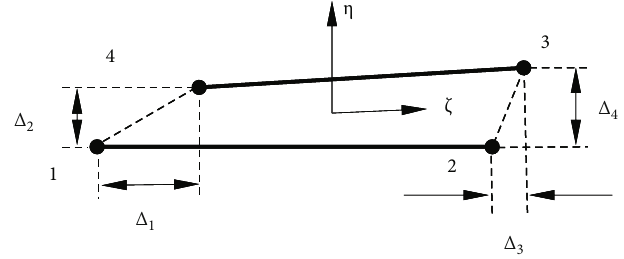
Figure 6: The normal and tangential separation in the local coordinates.